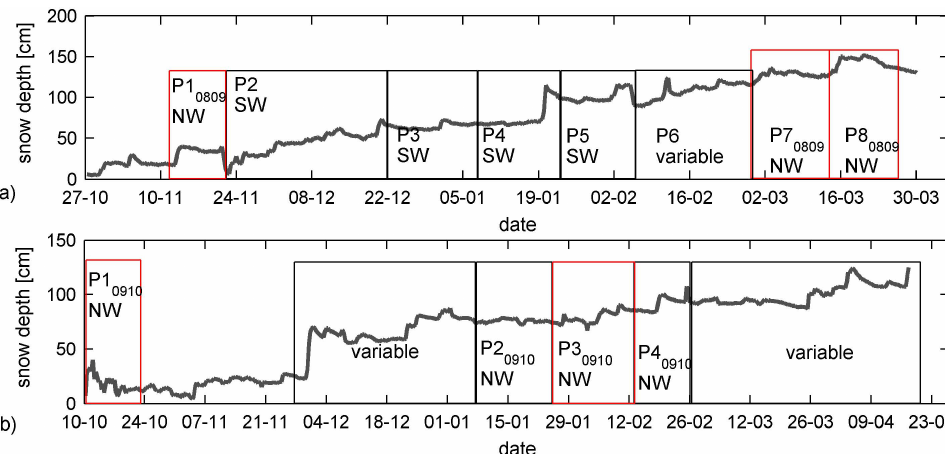
Fig. 2. Time series of snow-depth development during the accumulation seasons 2008/09 (a) and 2009/10 (b) at WAN 7. Snow-drift events are marked with boxes. Measured snow-drift events are additionally marked with P, and those events referred to in the paper are drawn in red.